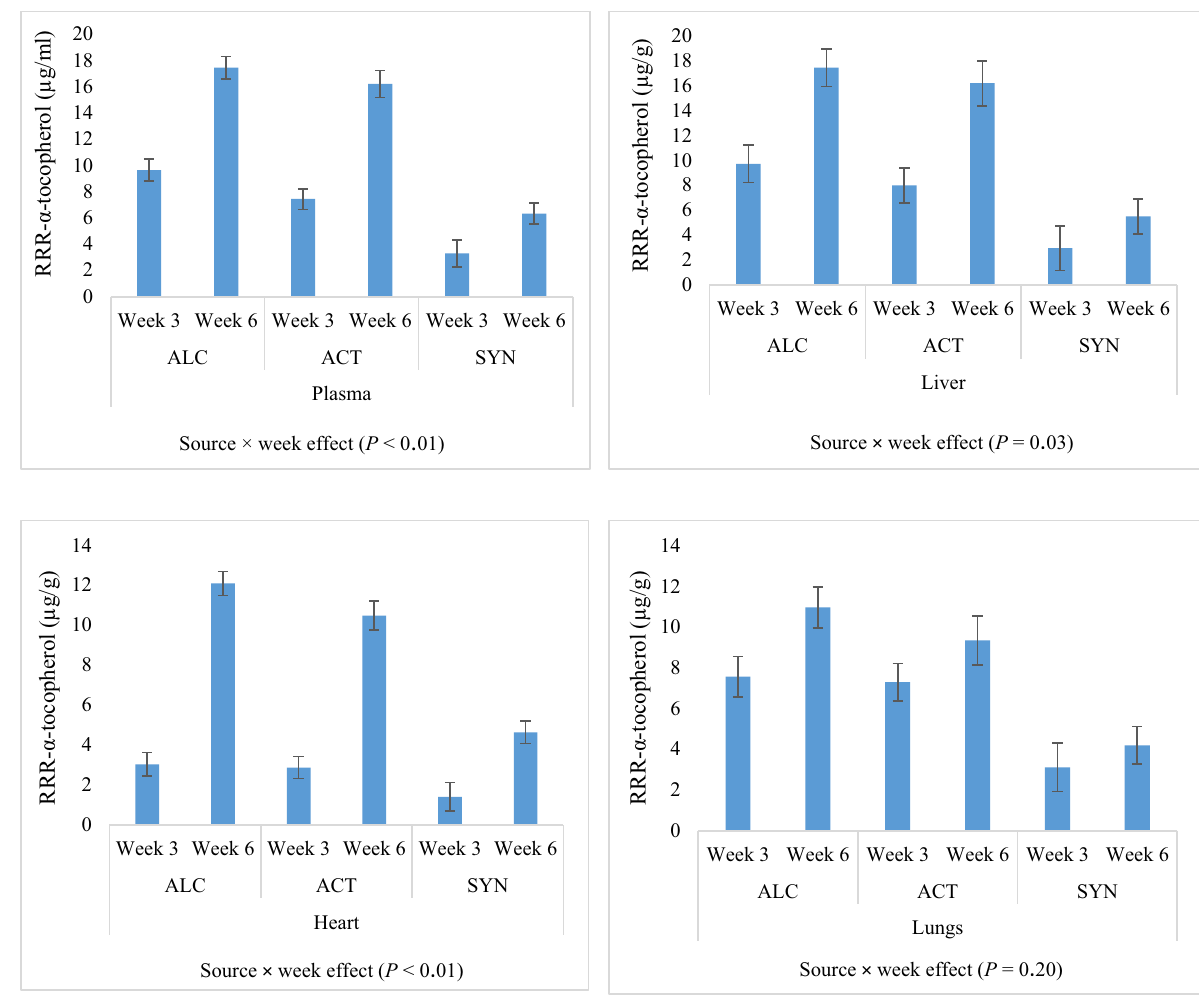
Figure 1. RRR-α-tocopherol of plasma, liver, heart and lungs 3 and 6 weeks after supplementation of RRR-α- tocopherol (ALC), RRR-α-tocopheryl acetate (ACT) and all-rac -α-tocopheryl acetate (SYN). Presented values are LS-means across dose ±